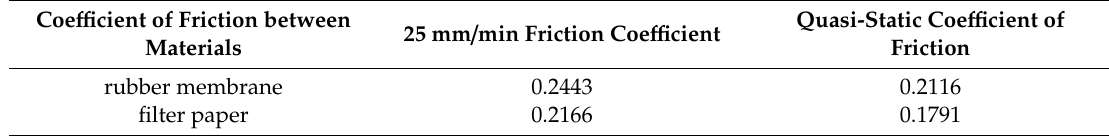
Table 4. Friction coefficients between glass beads and different materials.